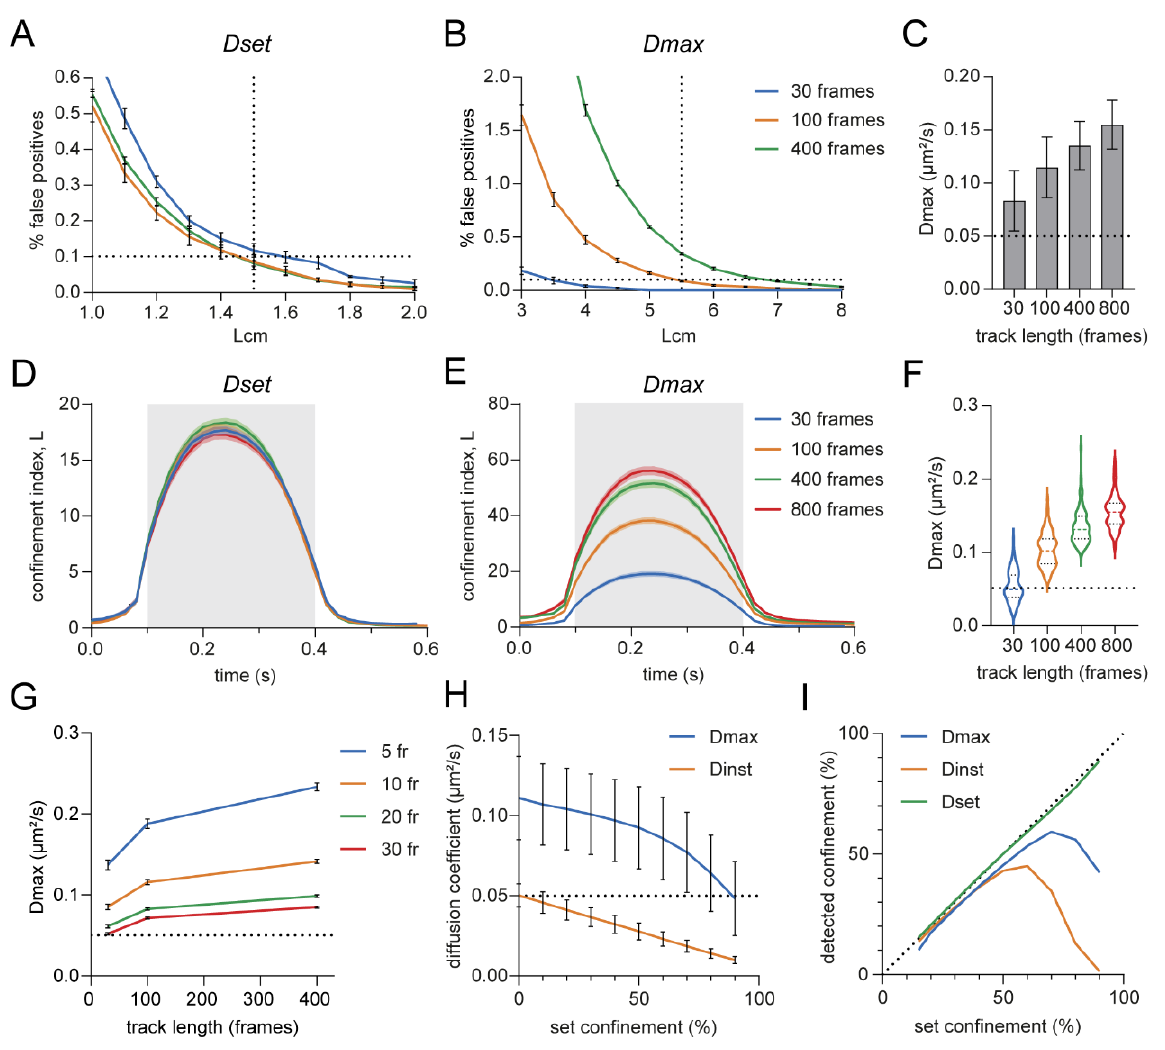
Figure 3. Effect of diffusion coefficient in the confinement index formula on confinement detection. ( A , B ) Effect of track length on the percentage of false positives in random walks using Dset ( A ) or Dmax ( B ) as diffusion coefficient in the confinement index formula. Five independent simulations of 1000 trajectories per condition. Data are represented as means ± SEM. ( C ) Effect of track length on Dmax. One hundred simulated random walks per condition. Data are represented as means ± SD. ( D , E ) Effect of track length on the confinement index over time using Dset ( D ) or Dmax ( E ) as diffusion coefficient in the confinement index formula. 100 confined trajectories per condition, Rconf = 0.02 µ m. Data are represented as means ± SEM. ( F ) Violin plots of Dmax values from ( E ). ( G ) Effect of the length of the segments used for estimating D inst within trajectories on Dmax. ( H ) Effect of the percentage of confinement within a trajectory on the estimated diffusion coefficient of the whole trajectory (Dinst) or the Dmax. One thousand trajectories per condition, Rconf = 0.04 µ m. Data are represented as means ± SD. ( I ) Effect of the percentage of confinement within a trajectory on the detected confinement within the trajectory using Dmax, Dinst or Dset. Dotted line indicates set confinement = detected confinement. One thousand trajectories per condition, Rconf = 0.04 µ